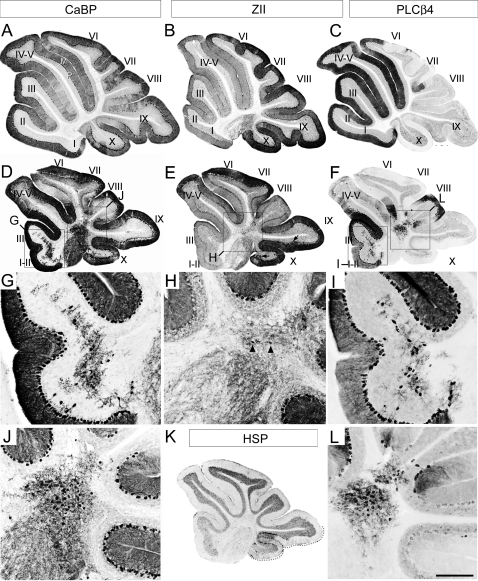
Adult Apoer2 null cerebella have Purkinje cell ectopia that is largely restricted to zebrin II-immunonegative cells.Sagittal sections are taken from either adult wild type (A–C) or Apoer2 null (D–L) cerebella. Cerebella have been immunostained with antibodies against calbindin (CaBP-A, D, G, J), zebrin II (ZII-B, E, H), phospholipase Cß4 (PLCß4-C, F, I, L) or heat shock protein 25 (HSP25-K) to reveal immunopositive Purkinje cell bodies in the Purkinje cell layer (P) as well as their dendrites located within the molecular layer (M). Sections from the Apoer2 null cerebellum are serial sections (zebrin II-calbindin-PLCß4) while wild type sections are not. Boxes in D–F indicate areas where higher-magnification pictures are presented below. High-magnification panels (G, H, I, J, L) illustrate the presence of discrete groups of ectopic Purkinje cells in the white matter of the Apoer2 null cerebellum, as identified with CaBP-immunostaining (G, J).The absence of zebrin II immunoreactivity in these cells (H) indicates that the predominant phenotype of Purkinje cells in the white matter of these mutants is ZII-/PLC ß4+ (I, L). Black arrows in E point to areas in lobules IX and X where Purkinje cells are misaligned within the Purkinje cell monolayer. Arrowheads in H point to the rare occurrence of zebrin II immunopositive Purkinje cells in the ectopic clusters. K–HSP25 immunoreactivity is revealed in Purkinje cells throughout the NZ (dotted line). Roman numerals indicate lobules. Scale bar in L = 1 mm for A–F and 250 µm for E–L.